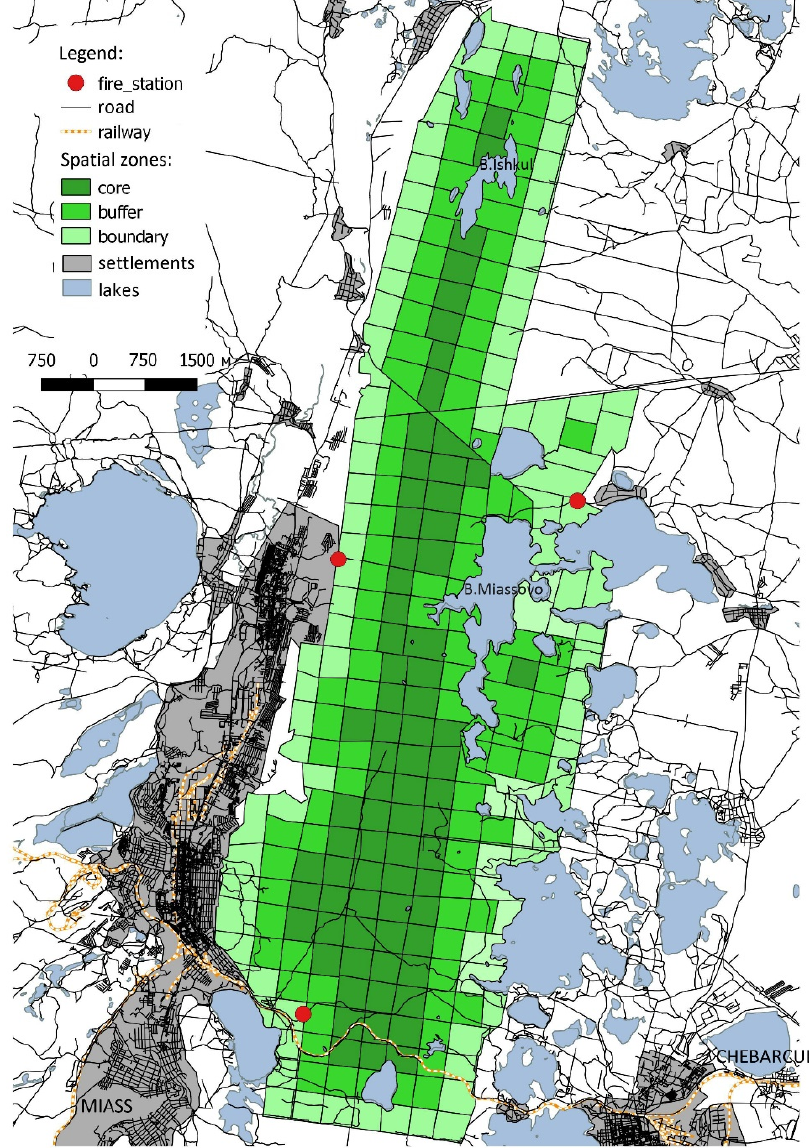
Figure 2. The spatial distribution of the zones of the Ilmensky